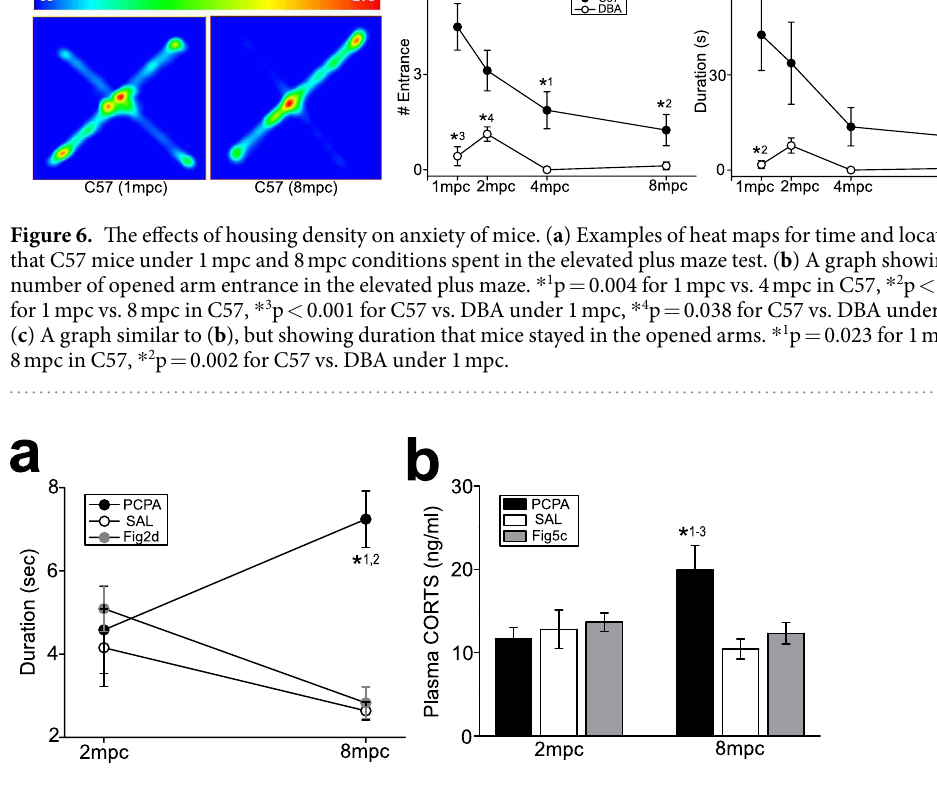
Figure 7. The effects of decreasing 5-HT availability on social interactions and stress hormones in C57 mice. ( a ) A graph showing duration of social interactions in mice with PCPA and control (SAL) treatments under 2 mpc and 8 mpc, and the data of C57 mice shown in Fig. 2d. * 1 p = 0.019 for PCPA vs. SAL under 8 mpc, * 2 p = 0.009 for PCPA vs. Figure 2d under 8 mpc. ( b ) A graph showing plasma CORTS concentrations in mice with PCPA and SAL treatments under 2 mpc and 8 mpc, and the data of C57 mice shown in Fig. 5c. * 1 p = 0.006 for PCPA vs. SAL under 8 mpc, * 2 p = 0.012 for PCPA vs. Figure 5c under 8 mpc, * 3 p = 0.042 for PCPA under 2 mpc vs. 8